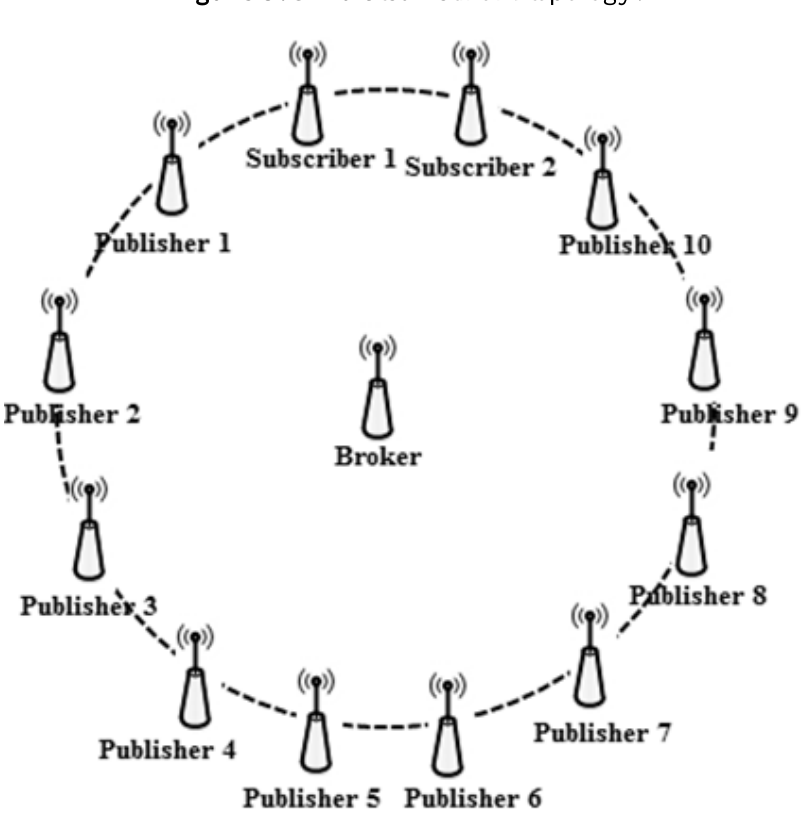
Figure 3. Simulated network topology.